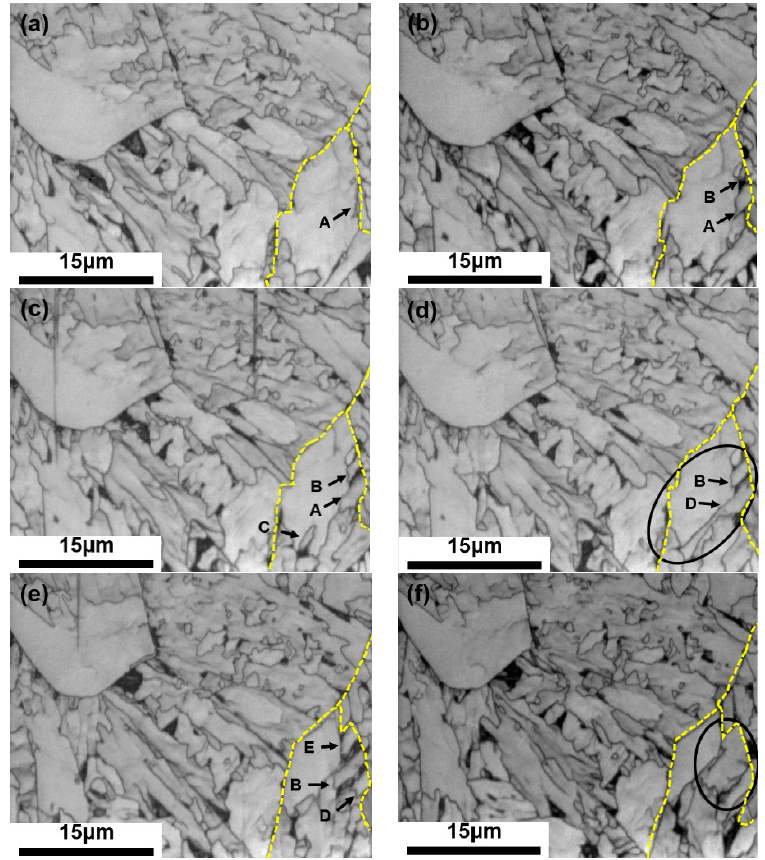
Figure 3. Scanning electron microscopy (SEM) image of primary Widmanstätten sideplates cutting process. ( a ) 110th layer, ( b ) 114th layer, ( c ) 117th layer, ( d ) 119th layer, ( e ) 127th layer, ( f ) 131st layer.